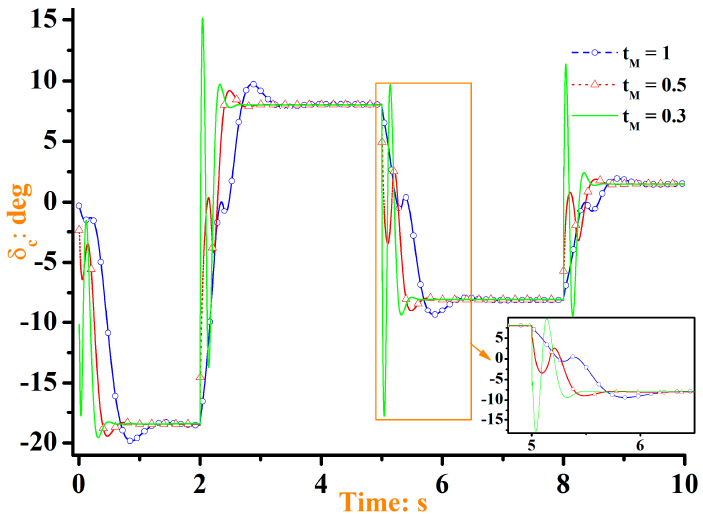
Figure 7. Validation with different predictive period t M : Tail deflection δ c